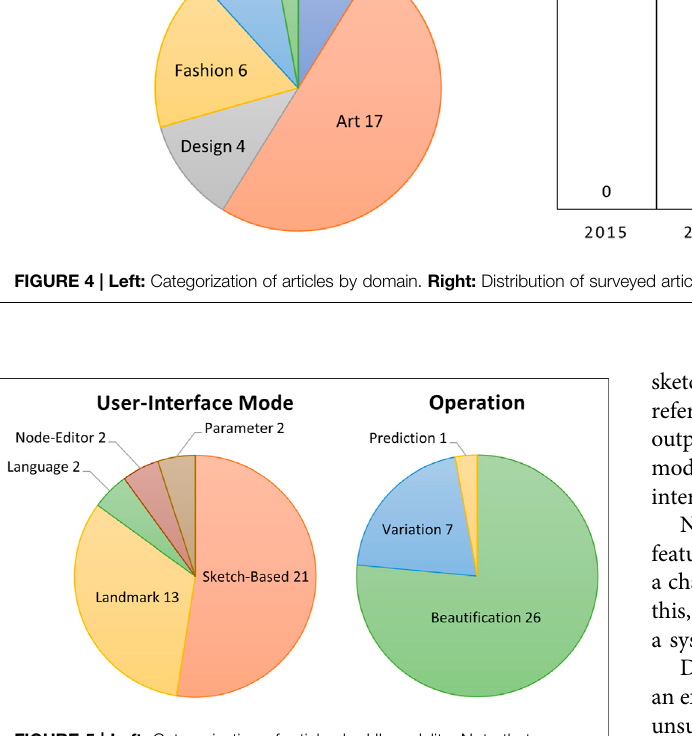
FIGURE 5 | Left: Categorization of articles by UI modality. Note that some articles were multifaceted and covered multiple categories. Right: Categorization of articles by UI modality. Note that some articles were multifaceted and covered multiple